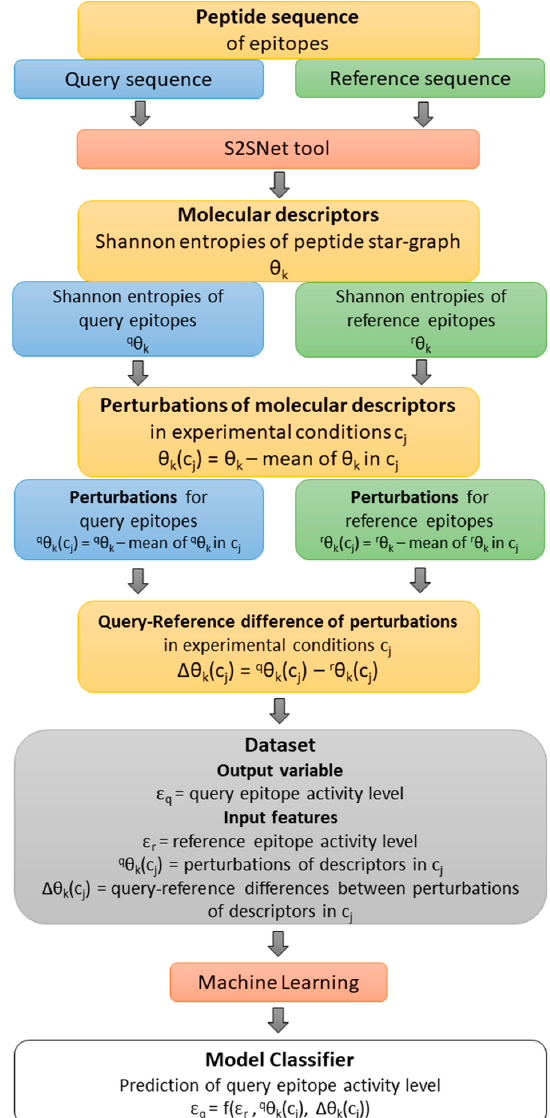
Figure 4. Methodology flow for building models to predict epitope activity level.